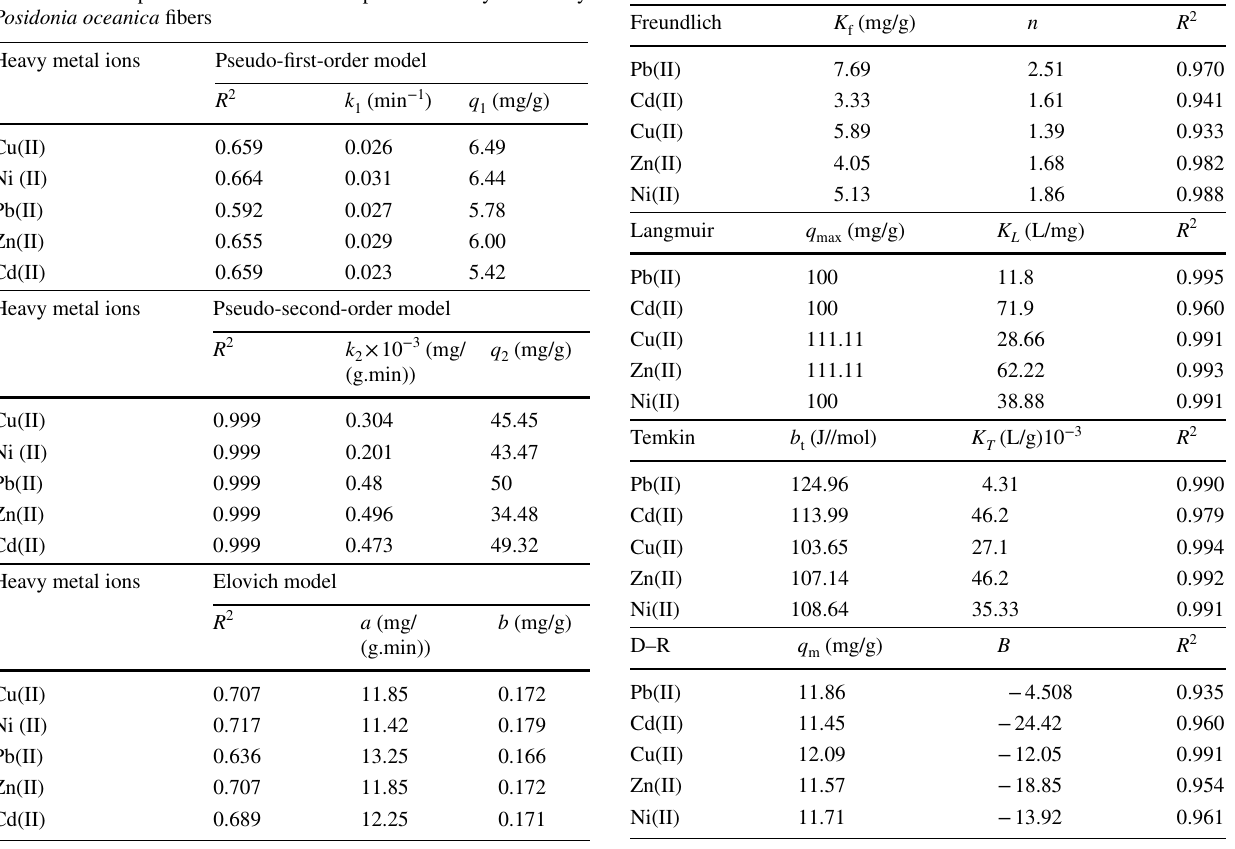
Table 3 Freundlich, Langmuir, Temkin and